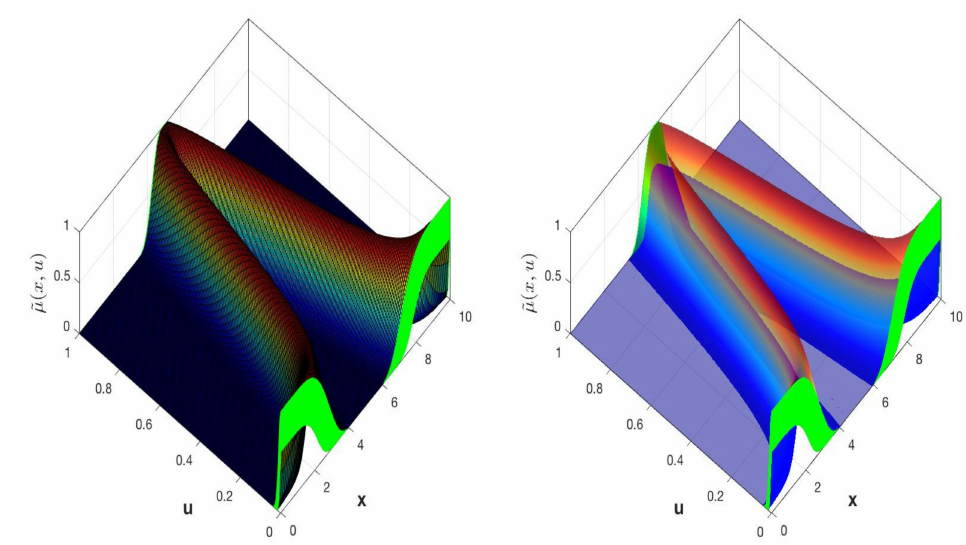
Figure 6. Isosurface of the MF of the IT3 FS.